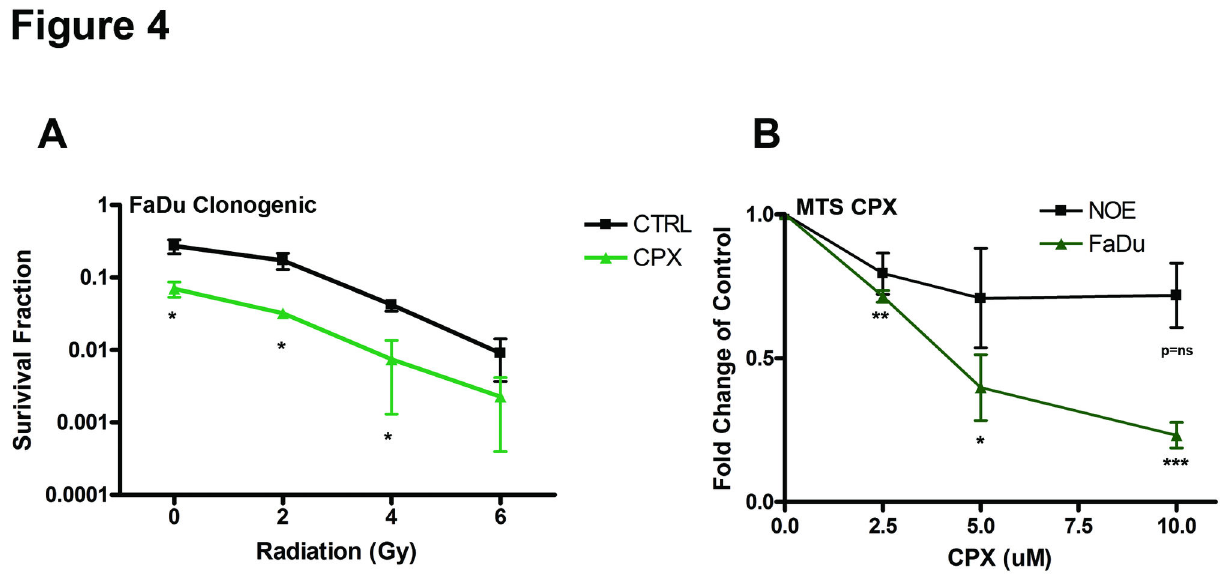
Figure 4. Ciclopirox olamine reduced HNSCC cell viability and clonogenicity. (A) Clonogenic survival of FaDu cells was measured 10 to 12 days after re-seeding of cells that were treated with ethanol (5 uM) or CPX (5 uM) for 72 hours, followed by RT (0, 2, 4 or 6 Gy). (B) Cell viability of FaDu and NOE cells was assessed by MTS assay 72 hrs after treatment with CPX (2.5 uM, 5 uM or 10 uM). *P<0.05, **P<0.005, ***P<0.0005, P=ns (not significant). doi: